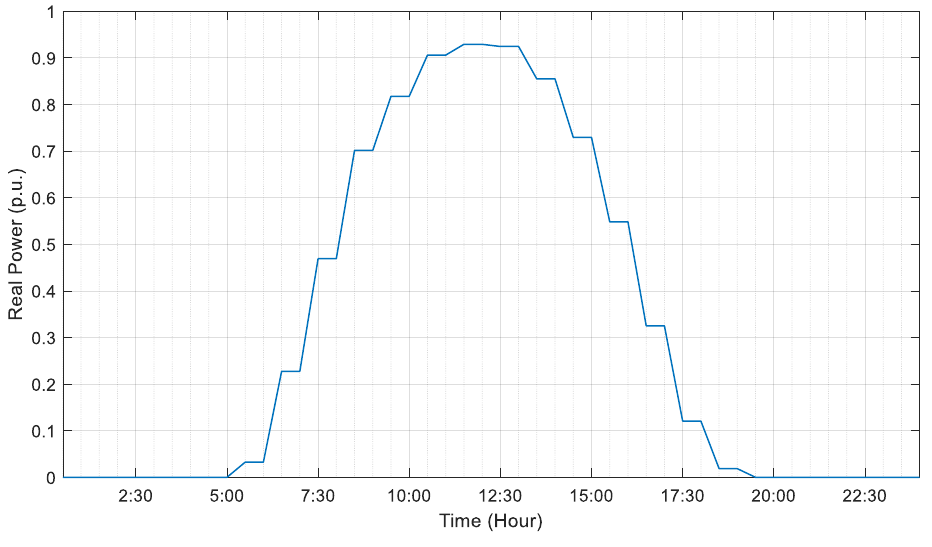
Figure 6. Output power of the interconnected PV.